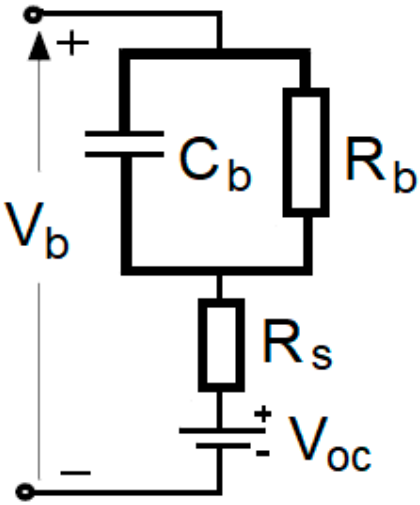
Figure 4. The schematic diagram of the battery.